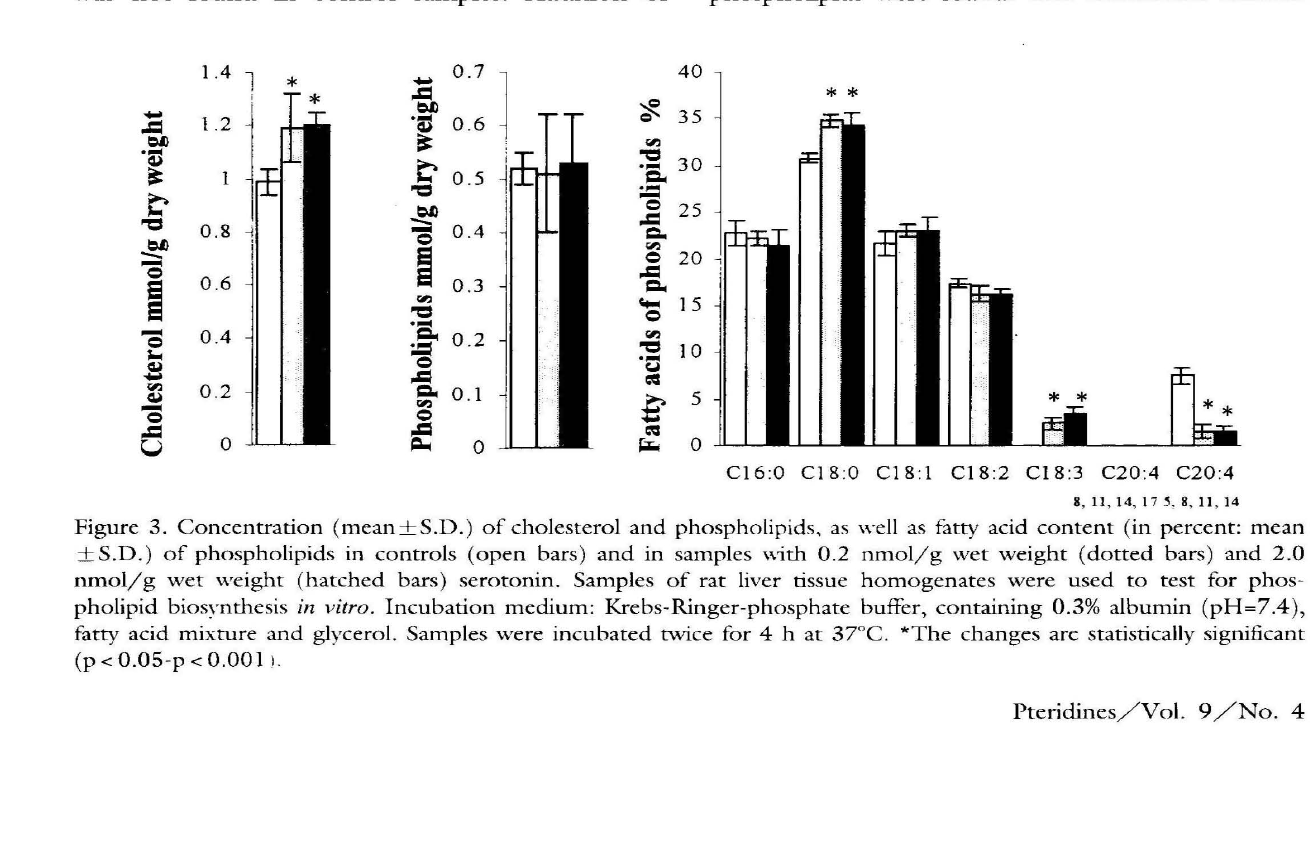
cholesterol content significantly decreased. Figure 3 shows the changes of phospholipid biosynthesis after addition of serotonin without an inhibitor of monoamine oxidase to samples. An increase of stearic and linolenic acid and a decrease of arachidonic acid incorpororation into phospholipids were found. The